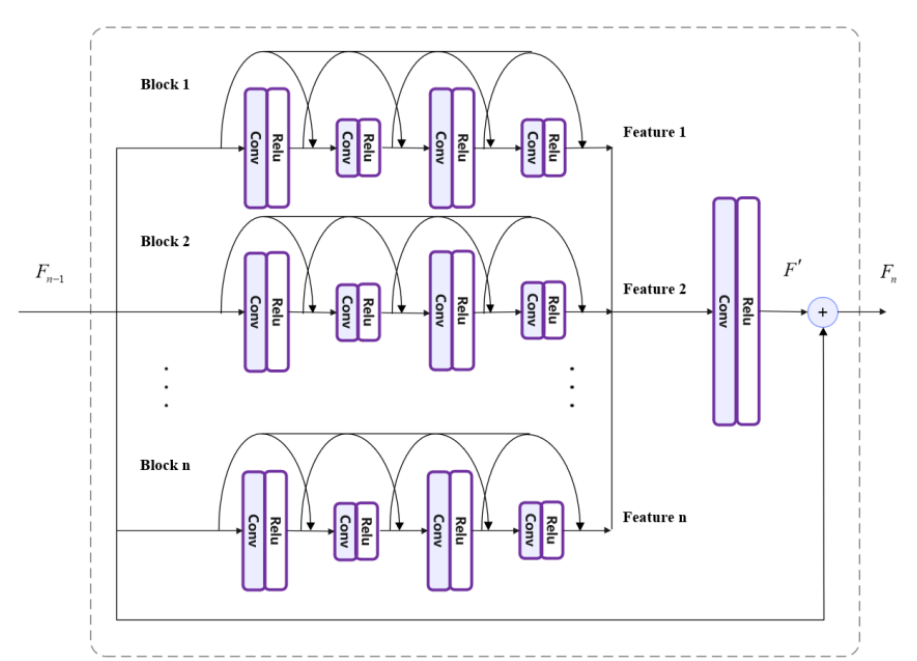
Figure 7. Dense connection module.